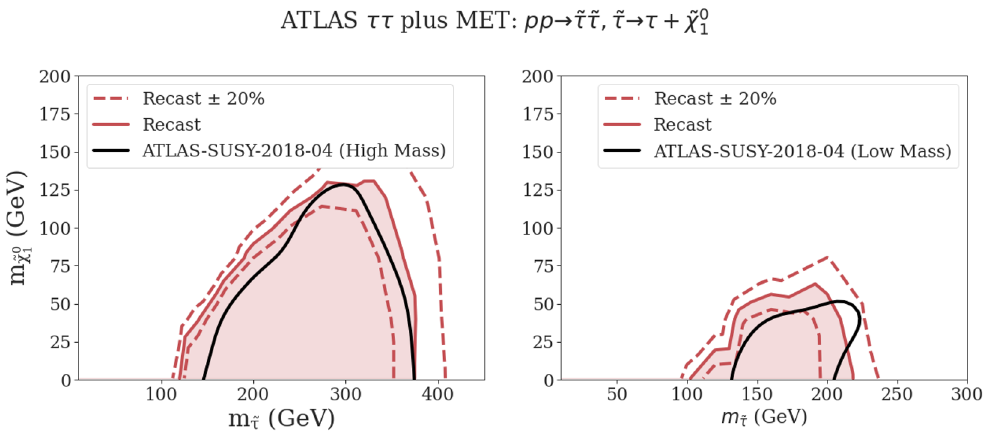
Figure 22 . Validation of the hadronic tau plus MET ATLAS search [60] implemented using CheckMATE 2 . The solid black line shows the official exclusion curve, while the solid red curve shows the one obtained through recasting. The left panel shows the results obtained for the high mass signal region, while the right panel displays the results for the low mass